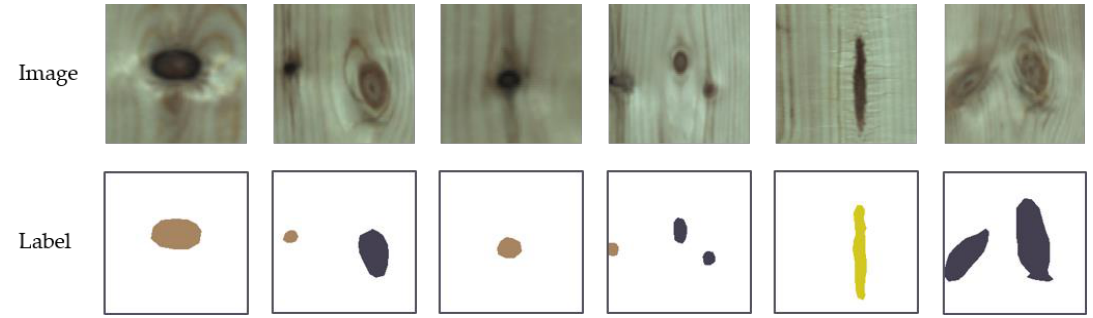
Figure 4. Defect images and corresponding label areas in the dataset. In label images after visualization, white represents the background, brown represents dead knots, dark blue represents live knots, and dark yellow represents cracks.